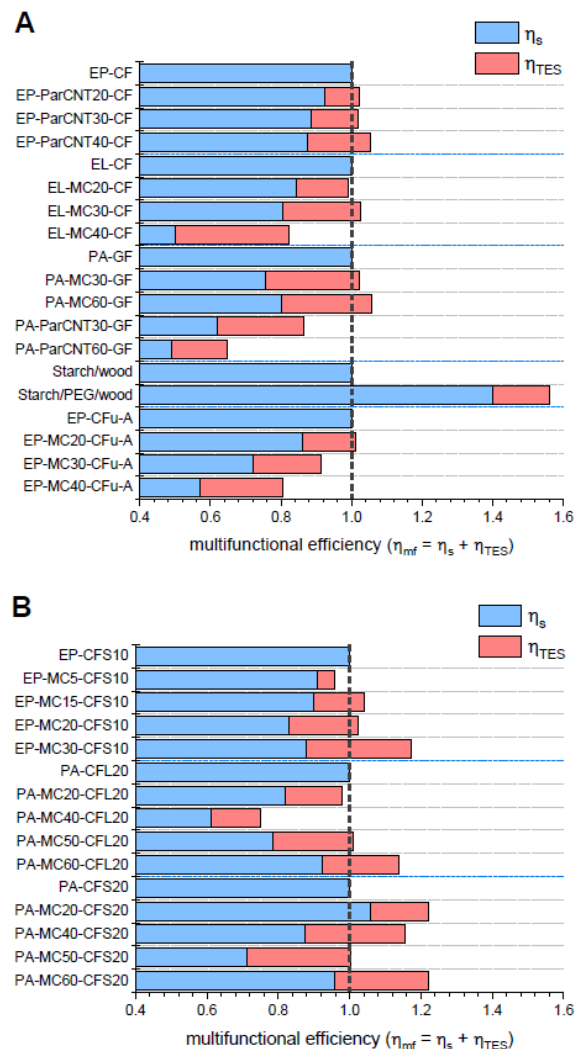
Figure 8. Multifunctional efficiency of the composites presented as the sum of structural and TES efficiencies. An effective mass saving is obtained when η mf is greater than 1. ( A ) Continuous-fiber composites; ( B ) discontinuous-fiber composites.